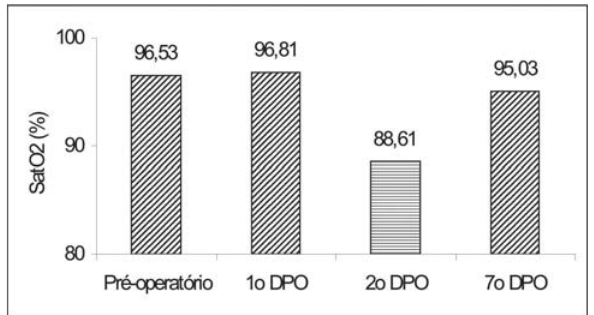
Fig. 3 – Média dos valores de saturação de oxigênio ao longo dos dias de